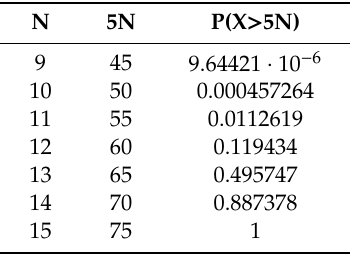
Table 3. Number of customers = 30N (k = 30).